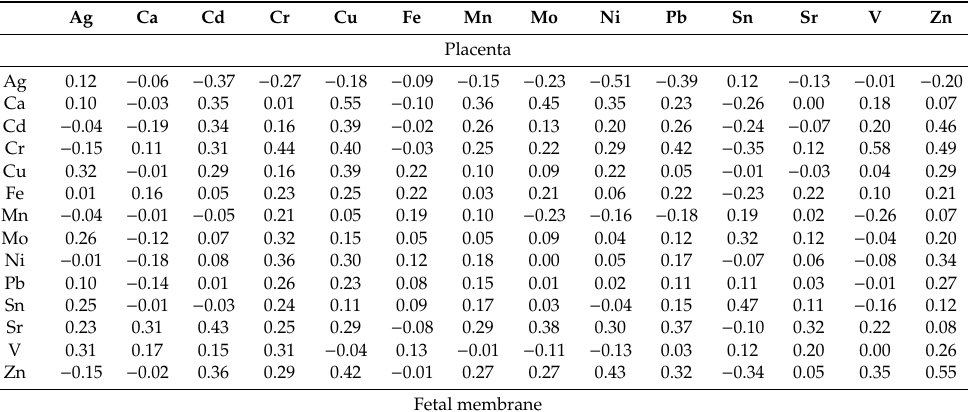
Table 3. Pearson’s correlation coe ffi cients between analyzed elements in the placenta and fetal membrane ( p < 0.05).